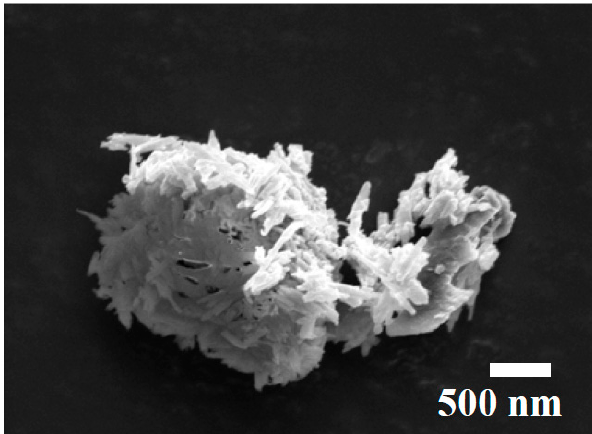
Figure 2. Image of halloysite nanotubes (HNTs).